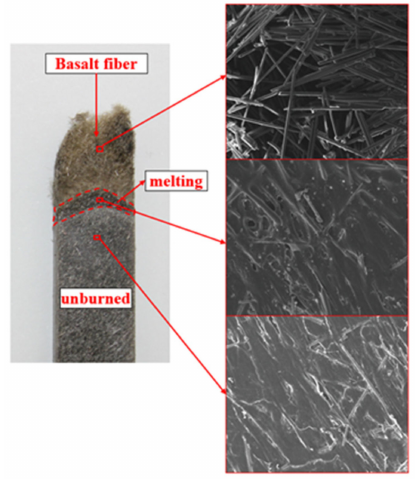
Figure 9. Photos of BFRPP sample after